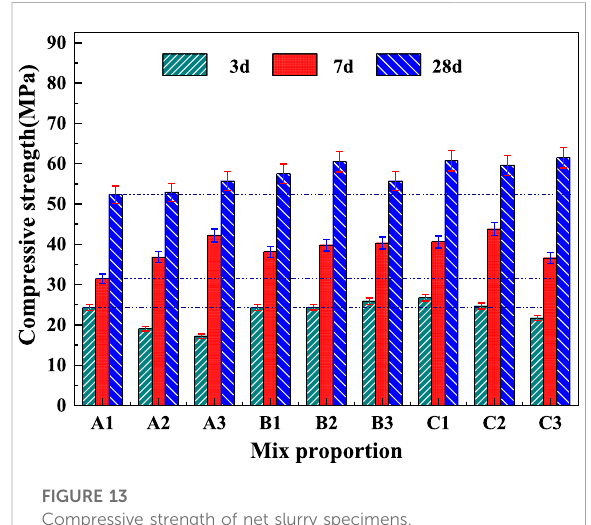
FIGURE 13 Compressive strength of net slurry specimens.